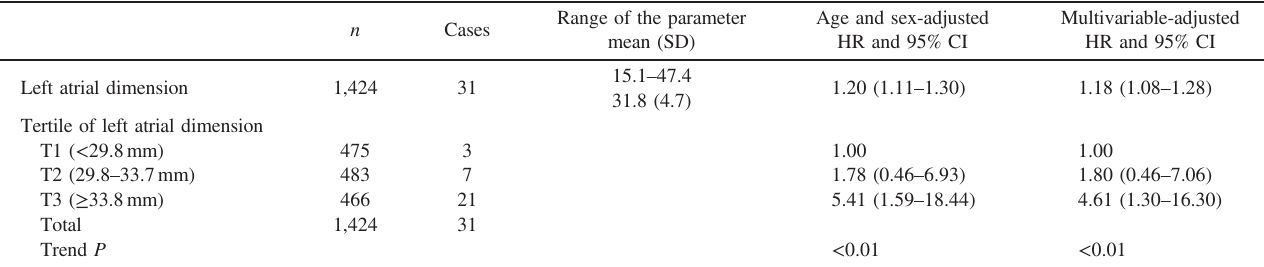
Range of the parameter Age and sex-adjusted n Cases mean (SD) HR and 95% CI